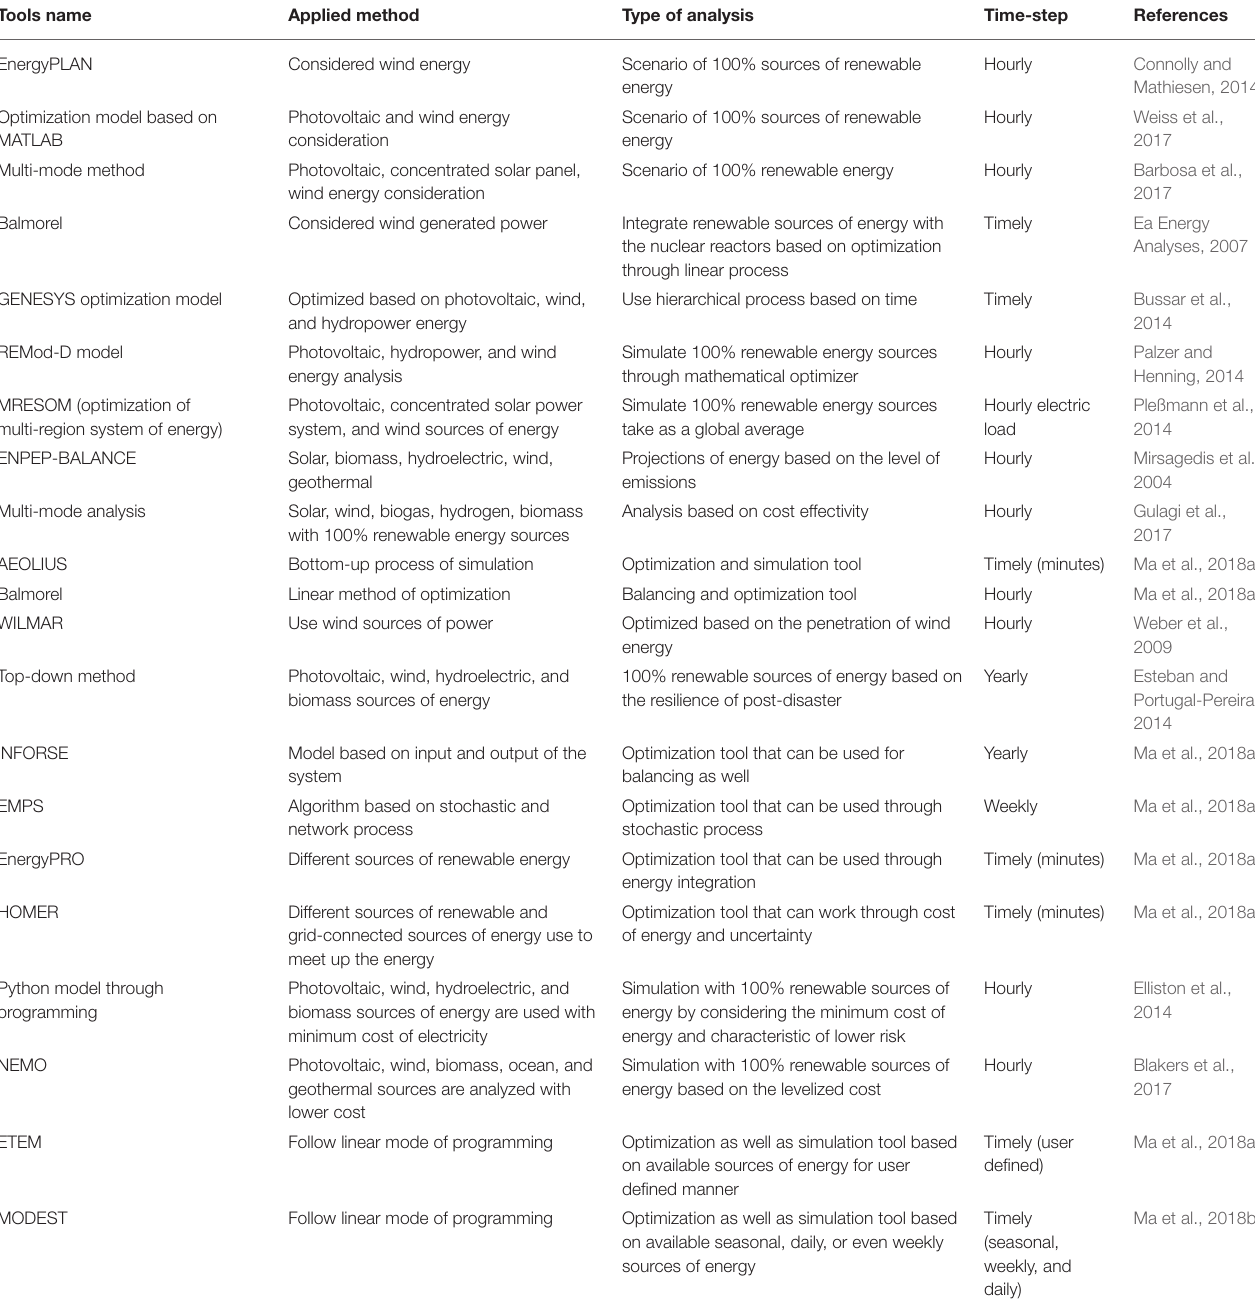
TABLE 5 | Different computer tools, software, methods, and optimization models for systems of hybrid nuclear renewable